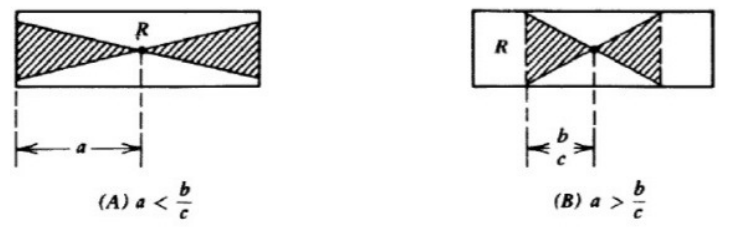
Figure 1. The rectangle R .